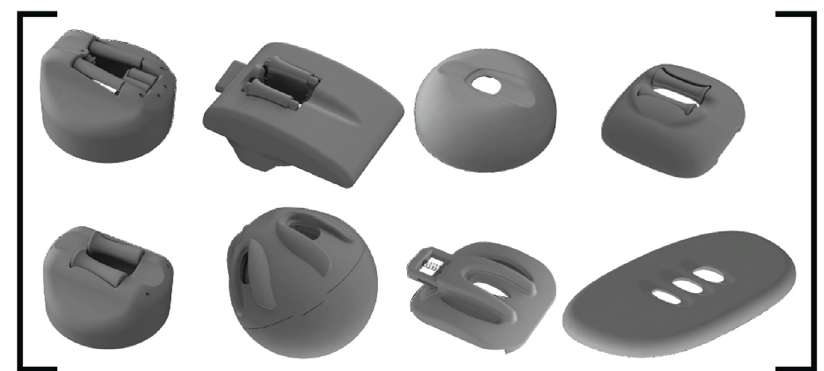
Figure 11. Examples of various non-contact hardware interaction designs (“tops”).